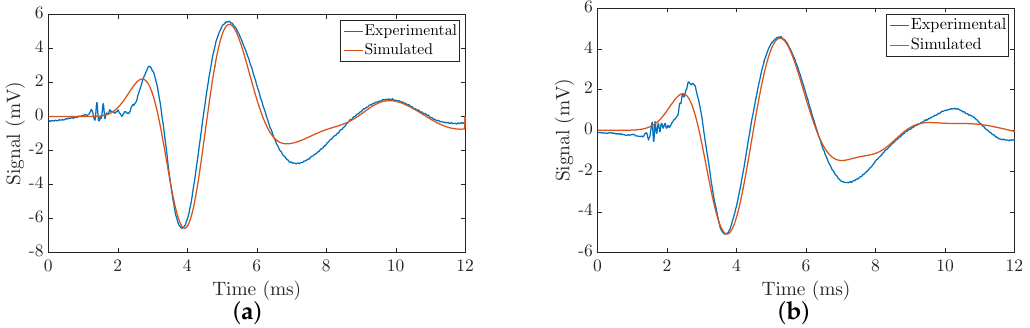
Figure 11. Examples of the fit of the experimental and simulated signals: Kelvin-Voigt model, time domain. ( a ) Phantom 1; ( b ) Phantom